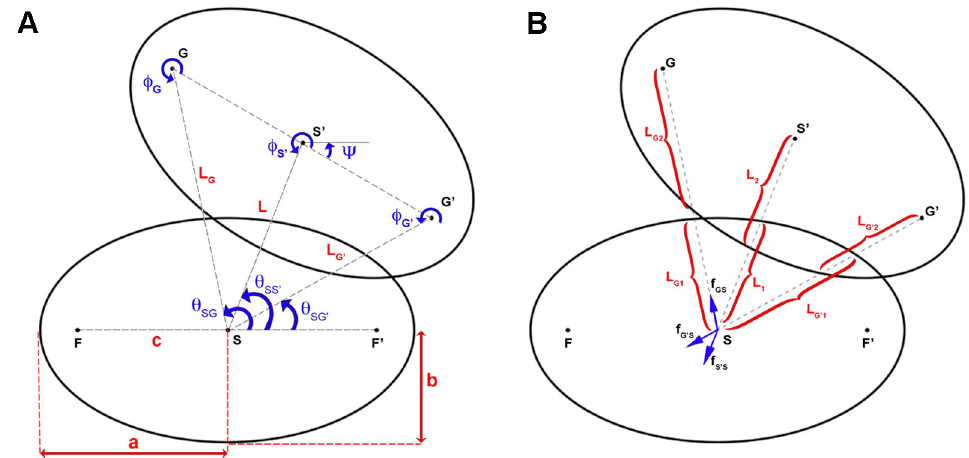
Fig 5. Model for agent elongation. To include agent elongation in the computational model, the circular agent at t = 0 is transformed to an ellipse with an increasing major axis in time. A) Definition of agents’ dimensions and their rotations. B) For two agents to be in equilibrium, sum of the forces from the centre and two foci of an agent on the other agent’s centre should be